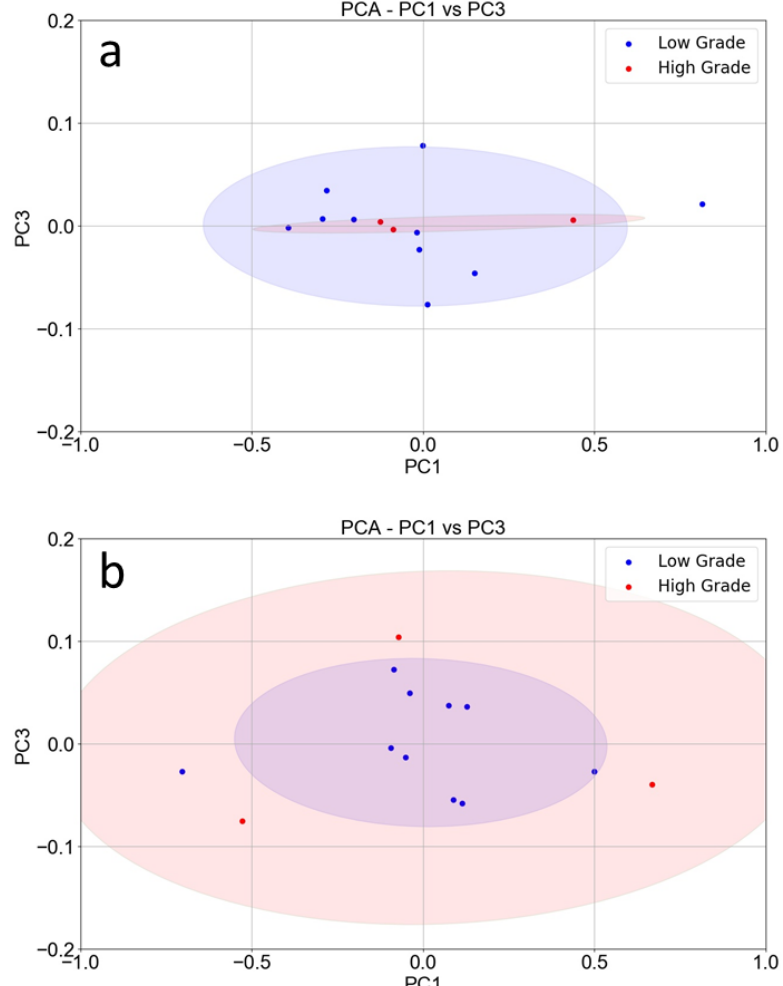
Figure 4. PCA of sensor responses related to tumor grade index: ( a ) PC1 vs. PC3 score plot constructed with the responses ( n = 13) of the ST25, W11, and TiTaV sensors to the healthy sample counterparts of the low-grade tumors (blue points) and to the high-grade ones (red points). ( b ) PC1 vs. PC3 score plot constructed with the responses ( n = 13) of the same sensors to the low-grade tumor samples (blue points) and to the high-grade ones (red points).